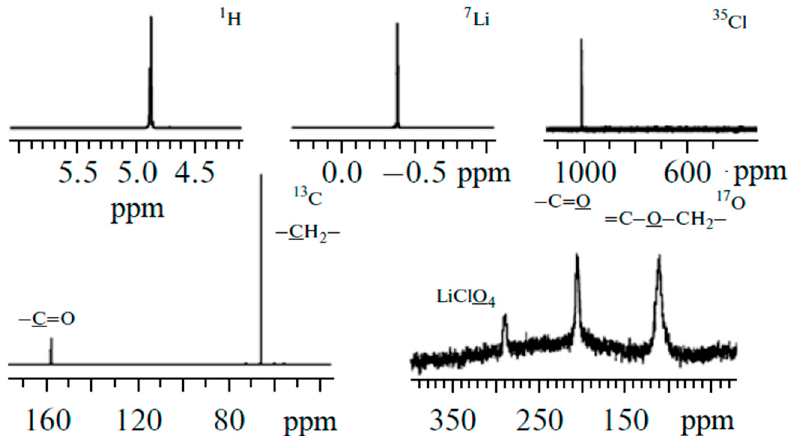
Figure 4. 1 H, 7 Li, 35 Cl, 13 C, and 17 O NMR spectra of LiClO 4 –ethylene carbonate solutions [120].